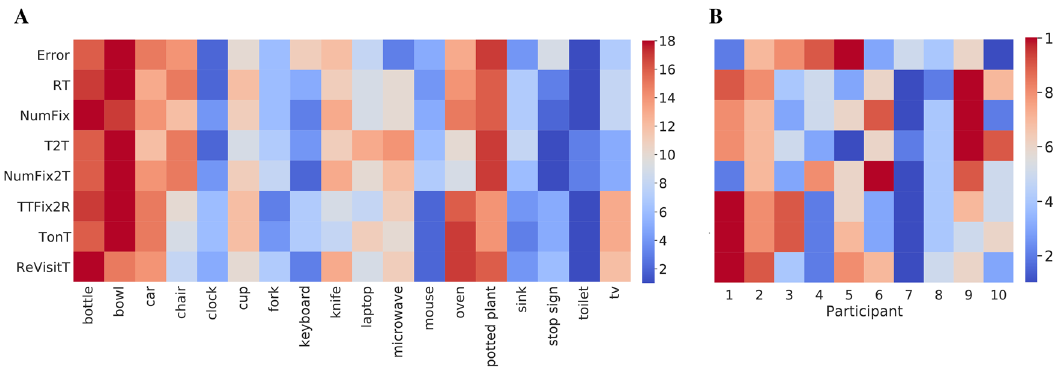
Figure 5. ( A ) Ranked target-category search efficiency [1–18], averaging over participants. Redder color indicates higher rank and harder search targets, bluer color indicates lower rank and easier search. Target category is grouped (columns) and shown for multiple performance measures (rows). These measures include: response Error, reaction time (RT), number of fixations (NumFix), time to target (T2T), number of fixations to target (NumFix2T), time from first target fixation until response (TTFix2R), time spent fixating the target (TonT), and the number of target re-fixations (ReVisitT). ( B ) A similar ranking of the target-present data, only now for participant efficiency (columns 1–10), averaged over target category. Performance measures and color coding are the same as in panel ( A